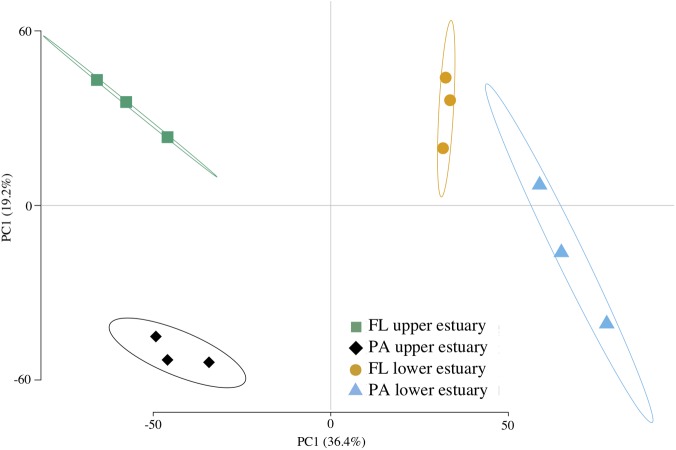
Euclidean distance PCA of functional community structure. Plotted data are KO RPKG relative abundance across samples based on metagenome CDS annotation. Ellipses represent 95% confidence intervals for centroid positions. FL, free-living; PA, particle-attached.